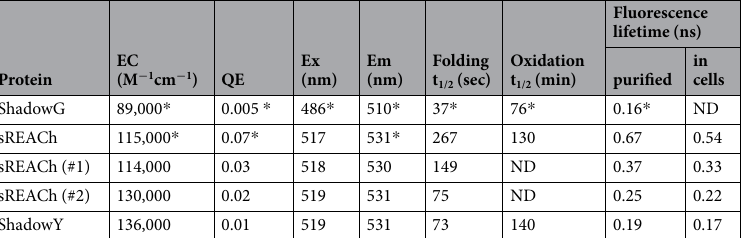
Table 1. Characteristics of ShadowY. EC: extinction coefficient, QE: quantum efficiency, Ex: excitation maximum, E m : emission maximum. * Values obtained from previously published data 8 . sREACh#1 contains the following mutations in sREACh: N144A, N146P, S147V, A206K, and R223F. sREACh#2 contains the following mutations in sREACh#1: Q204S and S205A. ShadowY contains the following mutations in sREACh#2: K166S and R168Y. ND: not